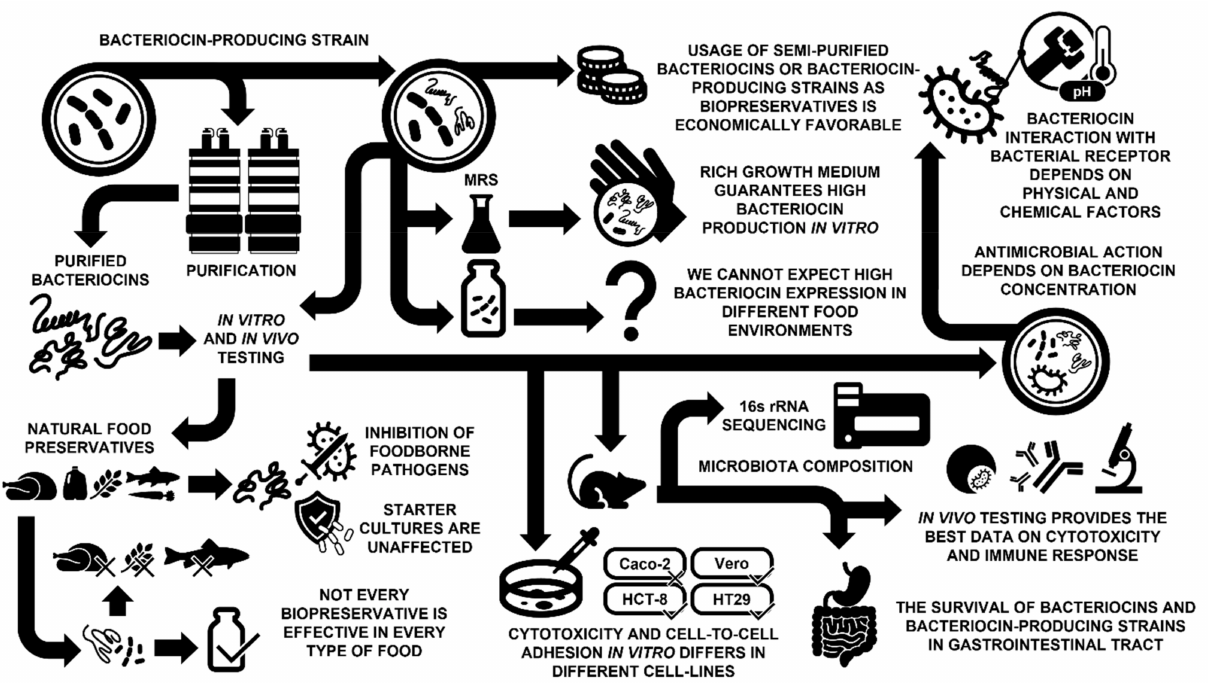
Figure 1. Keystone points in evaluation of potential application of bacteriocins as powerful antimi- crobials in biopreservation of food commodities and/or new generation of